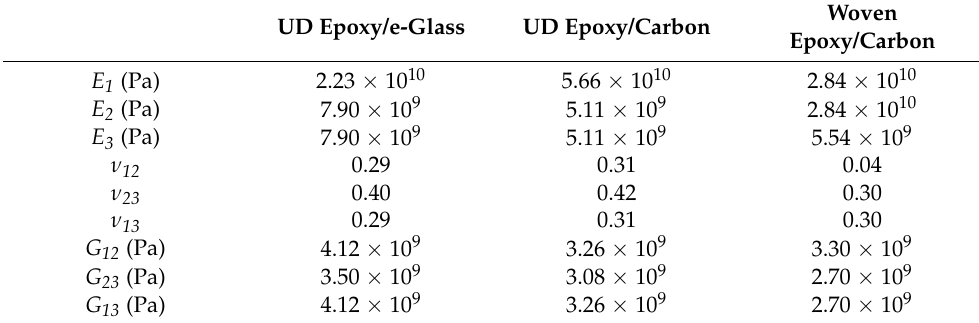
Table 1. Ply material properties.